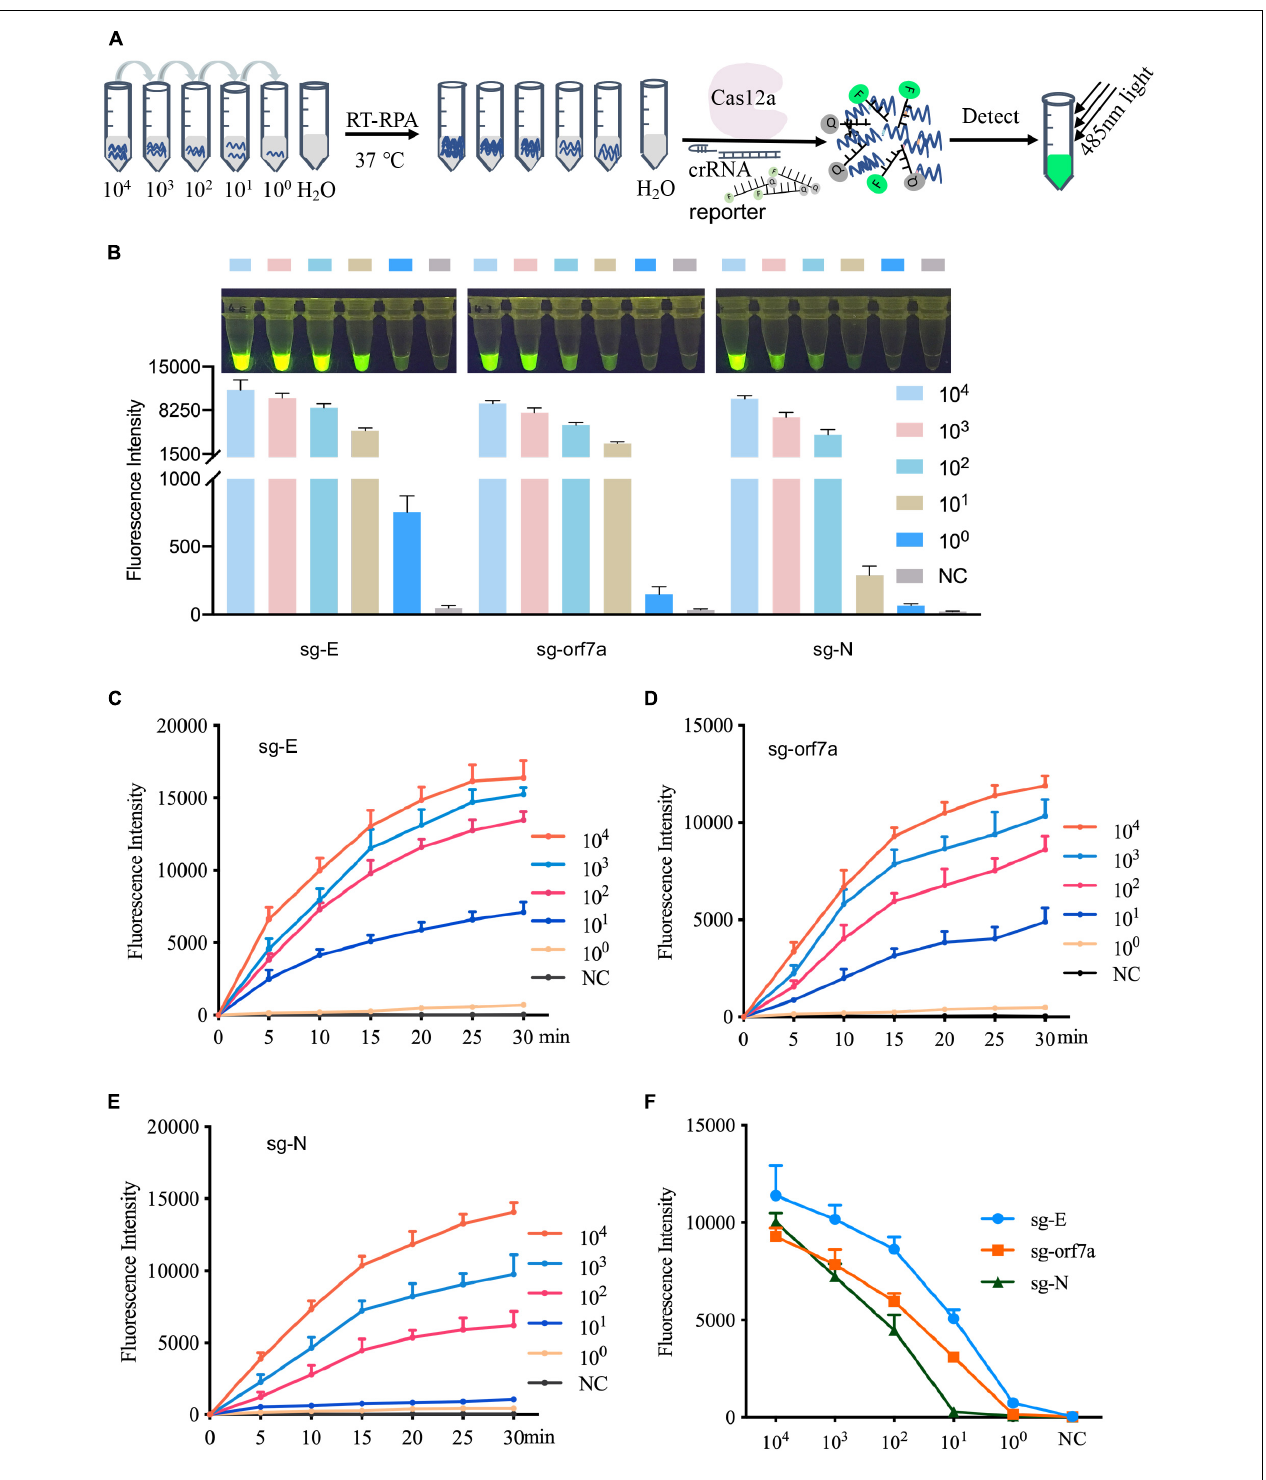
FIGURE 3 | Evaluate the sensitivity of the CRISPR-actCoV detection system. (A) An illustration of sensitivity evaluation assay using serially diluted sgRNA. Gradually diluted sgRNAs were subjected to RT-RPA followed by CRISPR/Cas12a mediated fluorescence reporter assay. (B) CRISPR-actCoV sensitivity evaluation assay. The fluorescent images (top panel) and intensities (bottom panel) at 15 min of the reaction were shown. Quantification of fluorescent images was performed using ImageJ. (C–E) A time-course assay of CRISPR-actCoV sensitivity in detecting sg-E (C) , sg-orf7a (D) , or sg-N (E) . The data was collected in a 5 min interval through 30 min. (F) Comparison of detection sensitivity of CRISPR-actCoV targeting sg-E, sg-orf7a, sg-N. Data were collected from at least three independent experiments and was presented as Mean ±